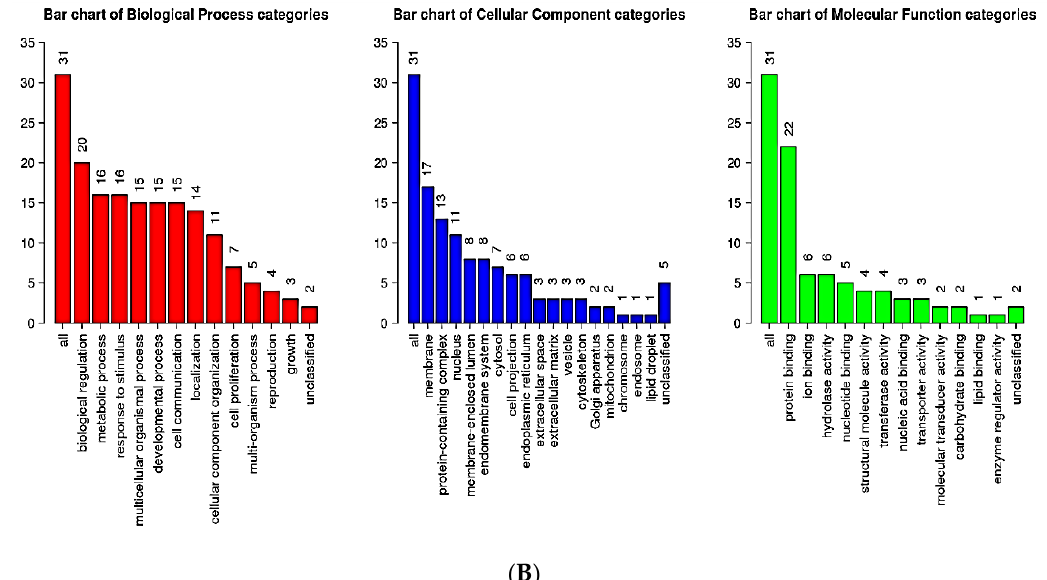
Figure 5. ( A ) Volcano plot of gene expression in adipocytes exposed to IS vs. control (CTL) (left panel) and IS+ pNaKtide (ISP) vs. IS expression (right panel) plotting antilog of unadjusted p -value on y-axis vs. log 2 Fold Change on x-axis. Genes downregulated (unadjusted p -value of <0.1) by IS colored orange and genes upregulated (unadjusted p -value of < 0.1) by IS colored blue. We note that addition of pNaKtide expression moved upregulated genes down and downregulated genes up. ( B ) Gene Ontology summary of over representation analysis (ORA) in IS treated murine adipocytes. Gene ontology annotation of biological processes, cellular components and molecular function categories.